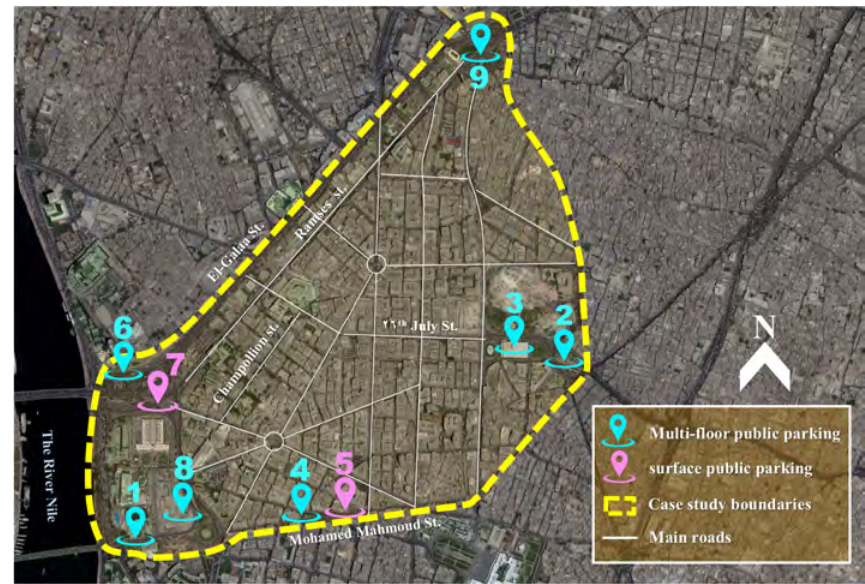
Figure 15. General public parking in the study area (Source: